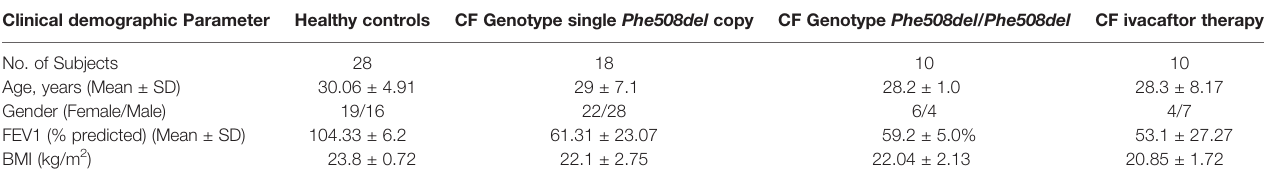
TABLE 1 | Clinical Demographics of patients and healthy controls recruited to this